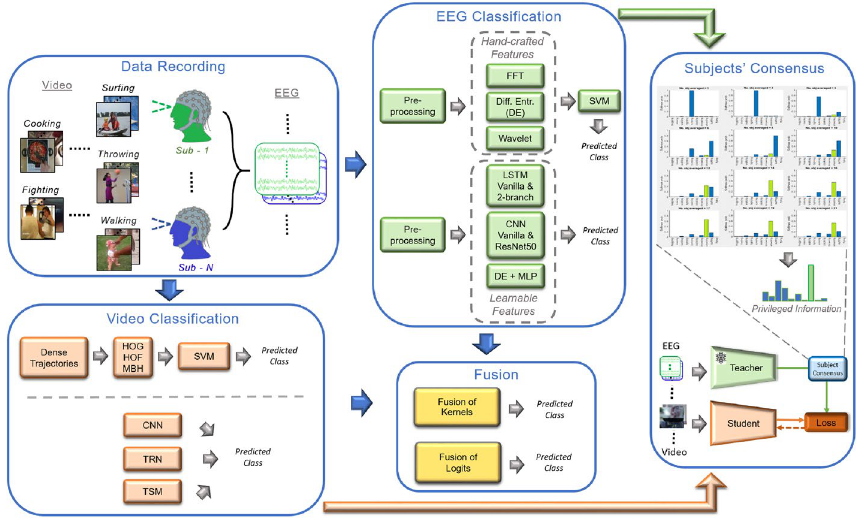
Figure 2. Overview of the several stages of the proposed work. We create the EEG dataset by collecting EEG recordings carrying implicit understanding of each actions’ video footage shown to different subjects (Data Recording). Next, we extract hand-crafted and learnable features to set up various baseline EEG classifiers as teacher model(EEG Classification) and video classifiers (Video Classification) as student model. Also, we prove through a baseline of fusion methods that the two sources of information are complementary (Fusion). Additionally, we show a strong subject consensus that, when averaging the predictions on models trained on different subjects and tested on the same video footage, the probability of predicting the correct class (green bar) increases. This serves as privileged information used to distill knowledge from EEG to Video model during training (subjects’